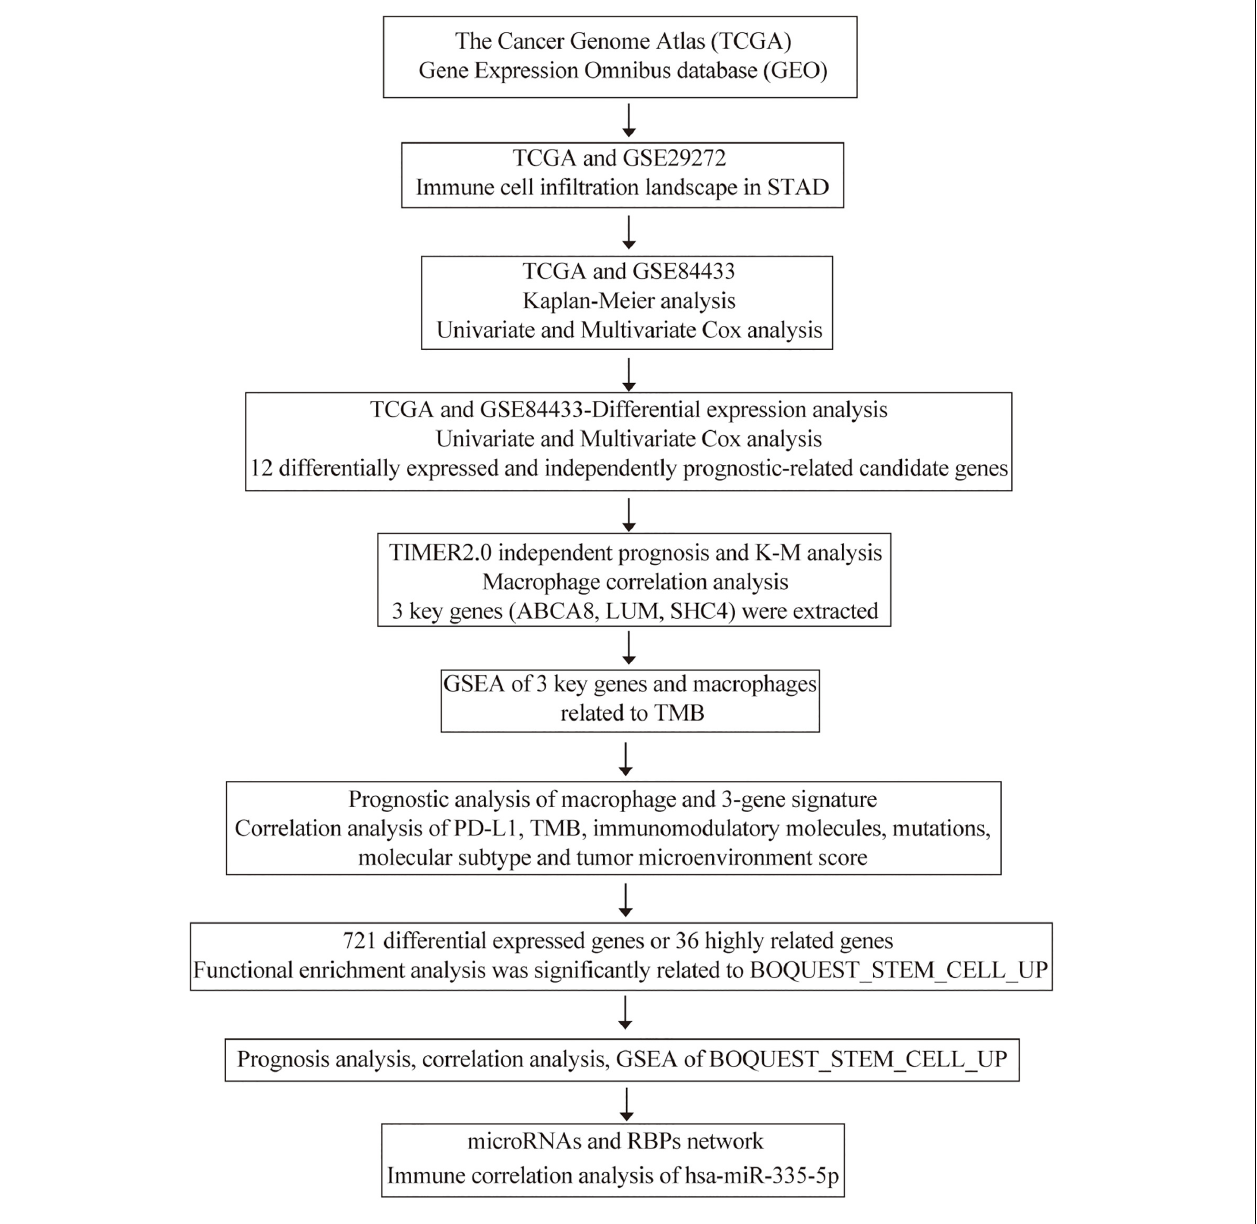
FIGURE 1 | The workflow of our